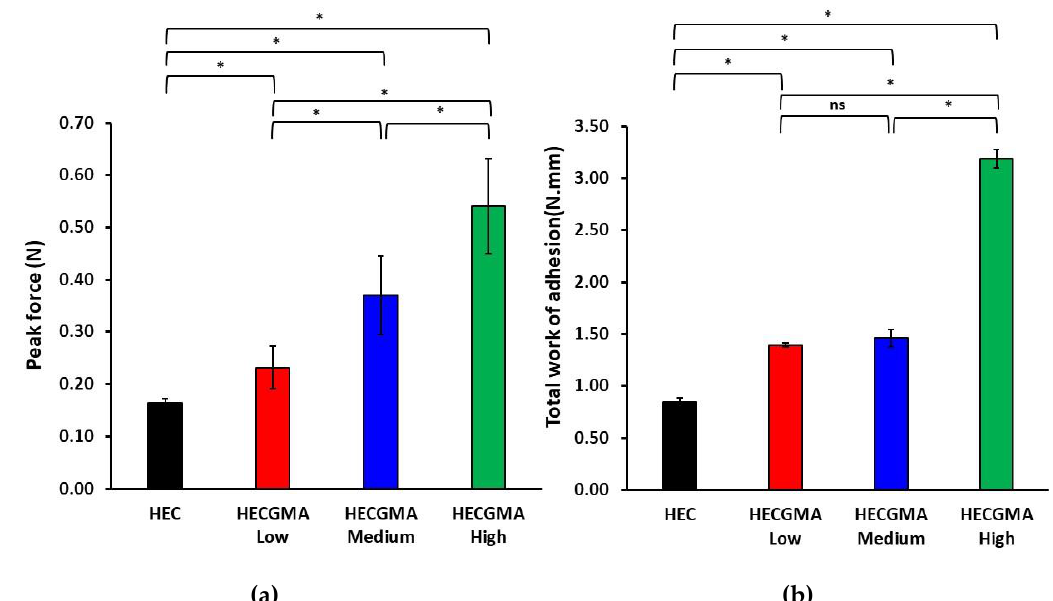
Figure 8. The results of tensile test to evaluate mucoadhesive properties of the wafers based on unmodified HEC and HECGMA derivatives: ( a ) Peak force (N) and ( b ) Total work of adhesion (mm·N). Data show the mean values ± SD (n = 5). * Statistically significant according to t -test; p < 0.05 ; ns = not significant.